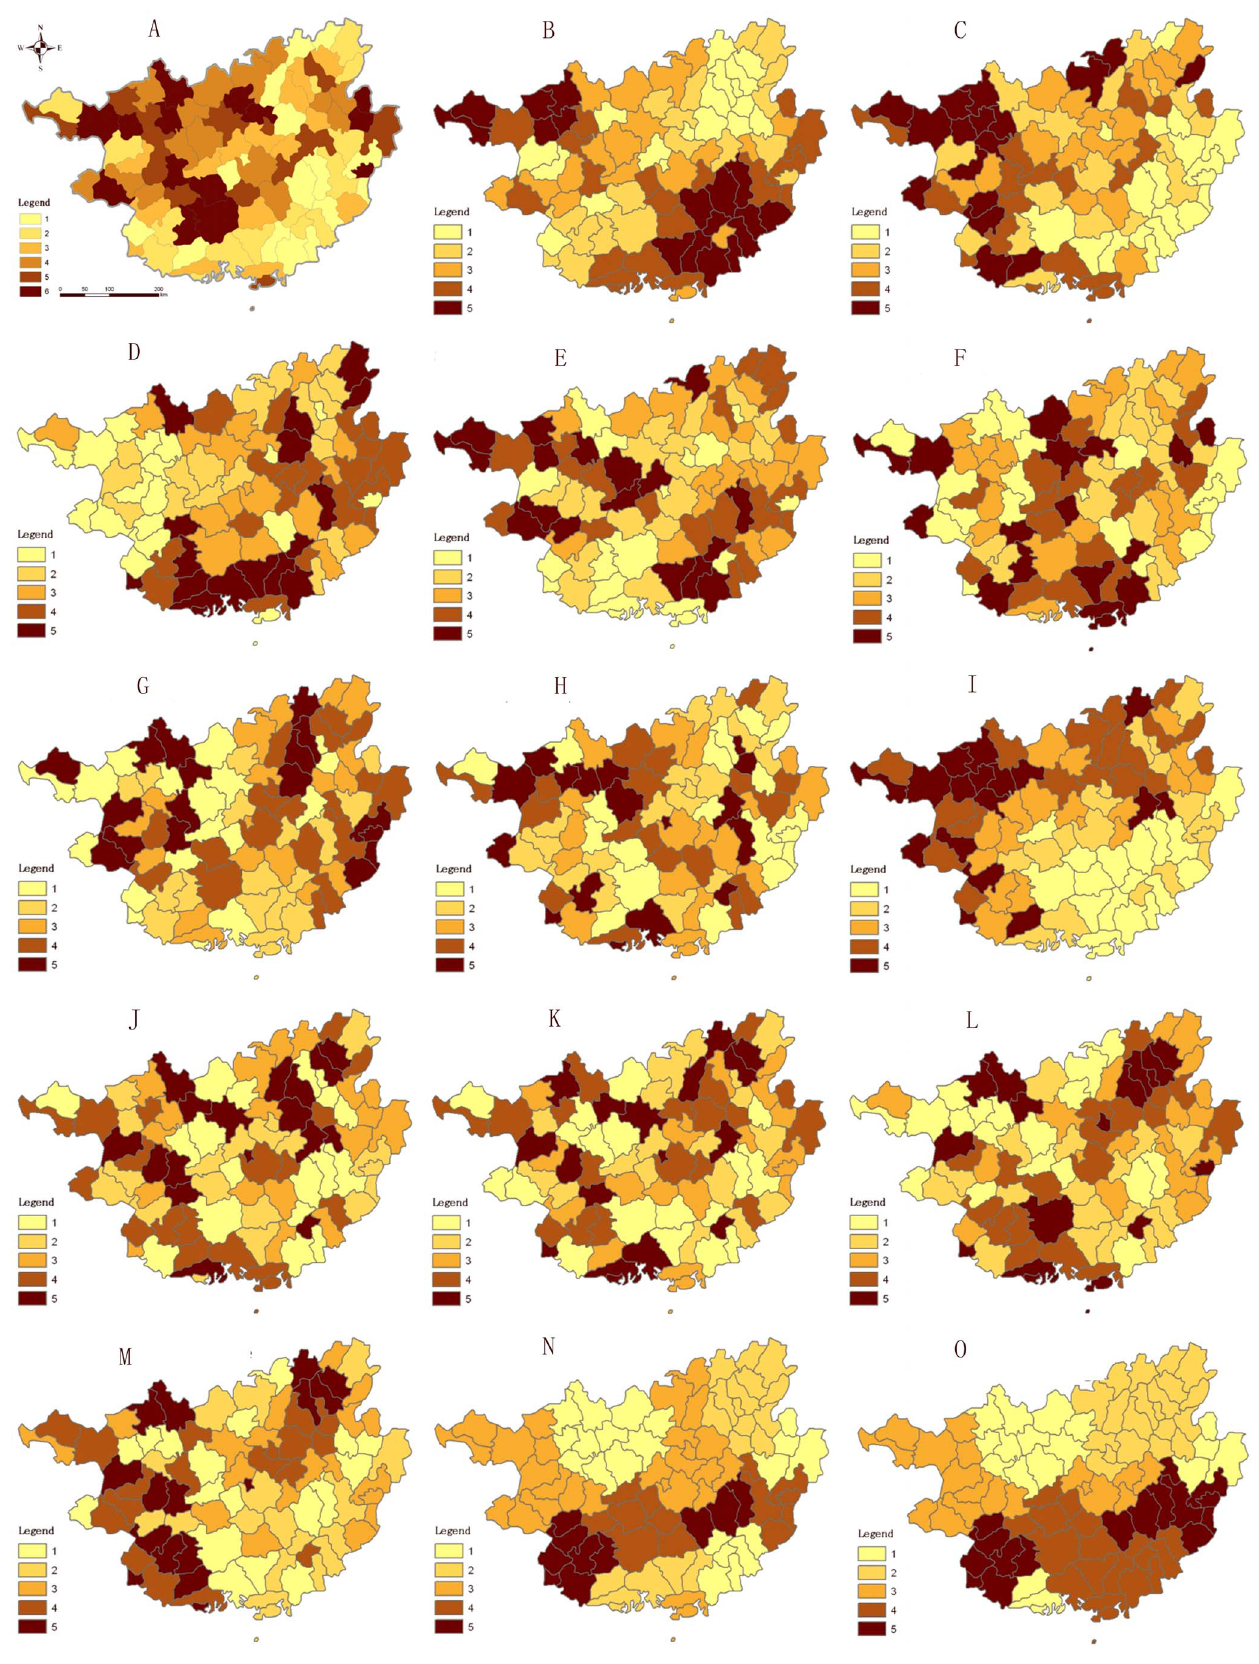
Figure 2. Spatial distributions of bacillary dysentery incidence and socio-economic factors. doi:10.1371/journal.pone.0102020.g002 PLOS ONE |